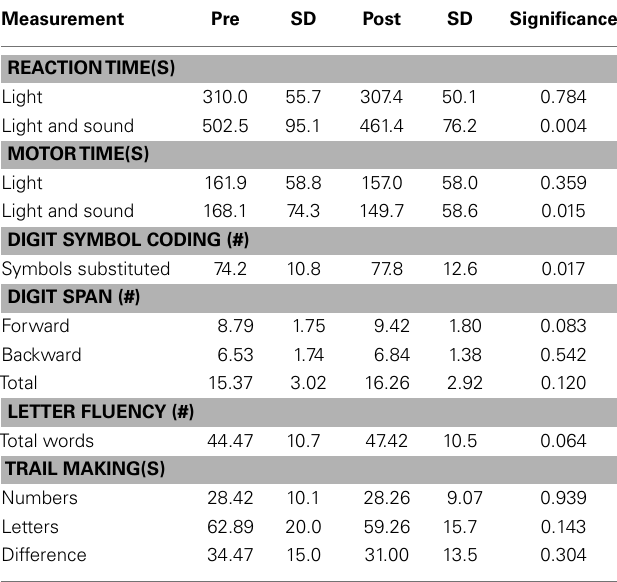
Table 2 | Outcome measurements